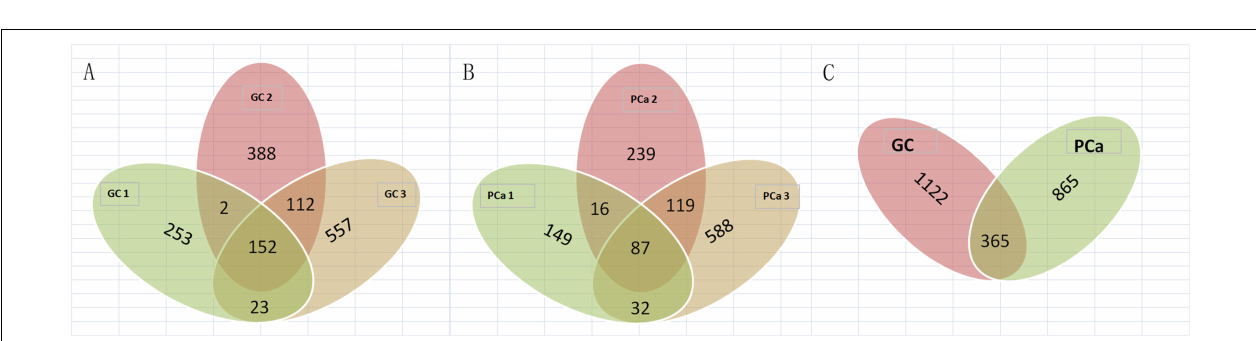
FIGURE 2 | Statistics for genes with m6A modifications in each sample. (A) Number of genes with m6A sites in three GC samples; (B) number of genes with m6A sites in three PCa samples; (C) number of genes in GC and PCa tissues. We detected 1,487 m6A genes in GC tissues and 1,230 genes in PCa tissues, respectively, 365 genes were comethylated in GC and PCa tissues, accounting for 15.52% of the total methylated genes; 1,122 and 865 genes were only methylated in GC and PCa tissues,